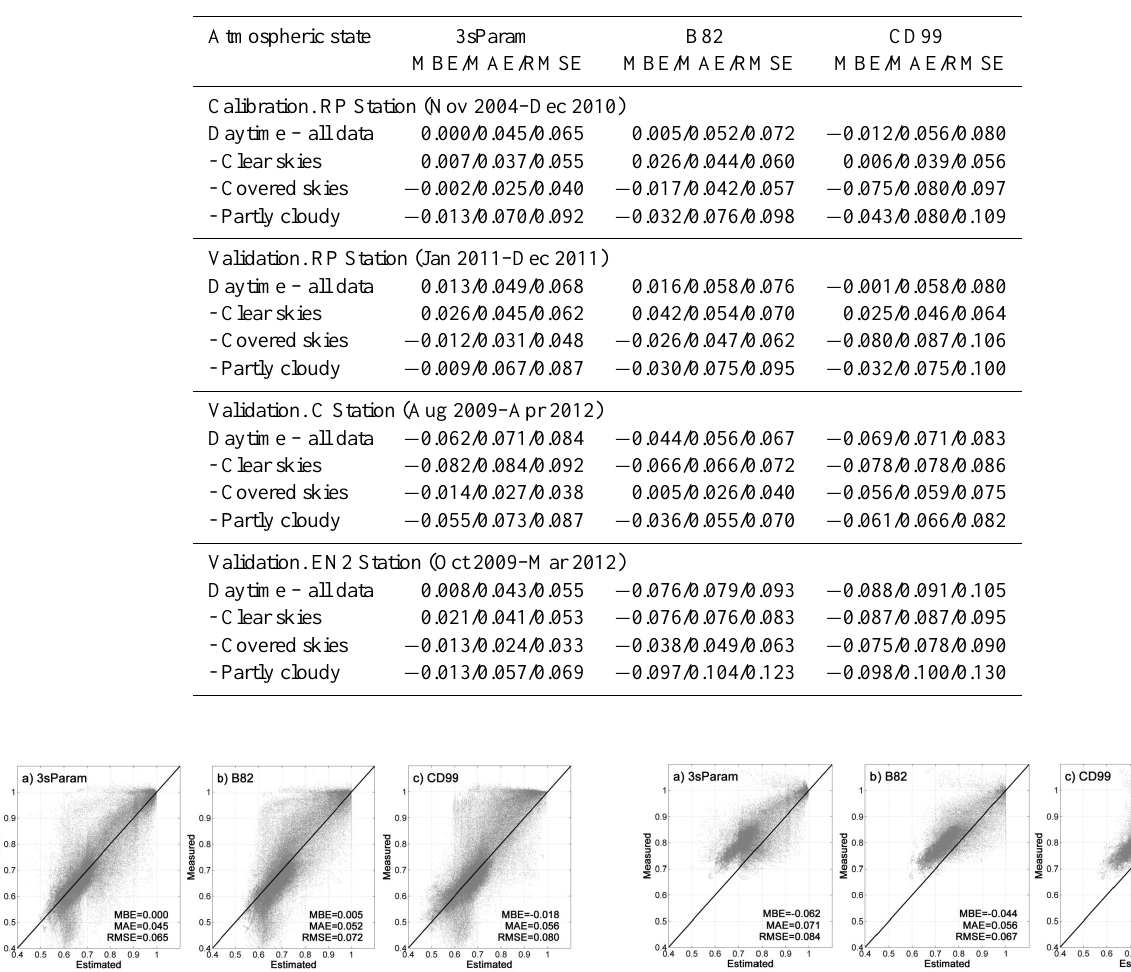
Table 1. Summary of the goodness of agreement for the new 3-state parameterization (3sParam), Eqs. (4) to (7), the Brutsaert equation (B82), and Crawford and Duchon (1999) (CD99), both locally calibrated, for different atmospheric states for the calibration and validation